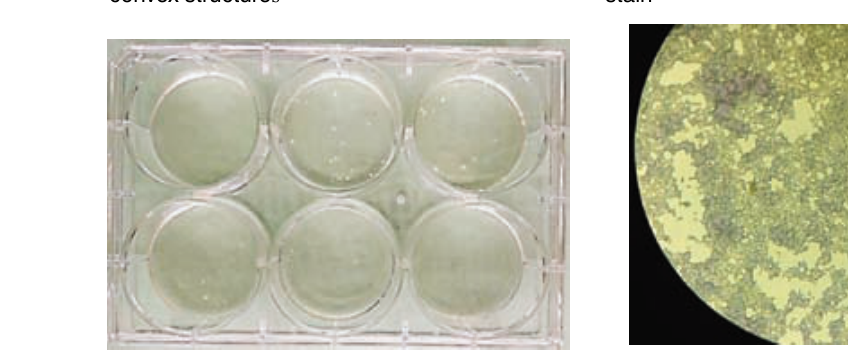
Fig. 5. Colonies on polystyrene plate